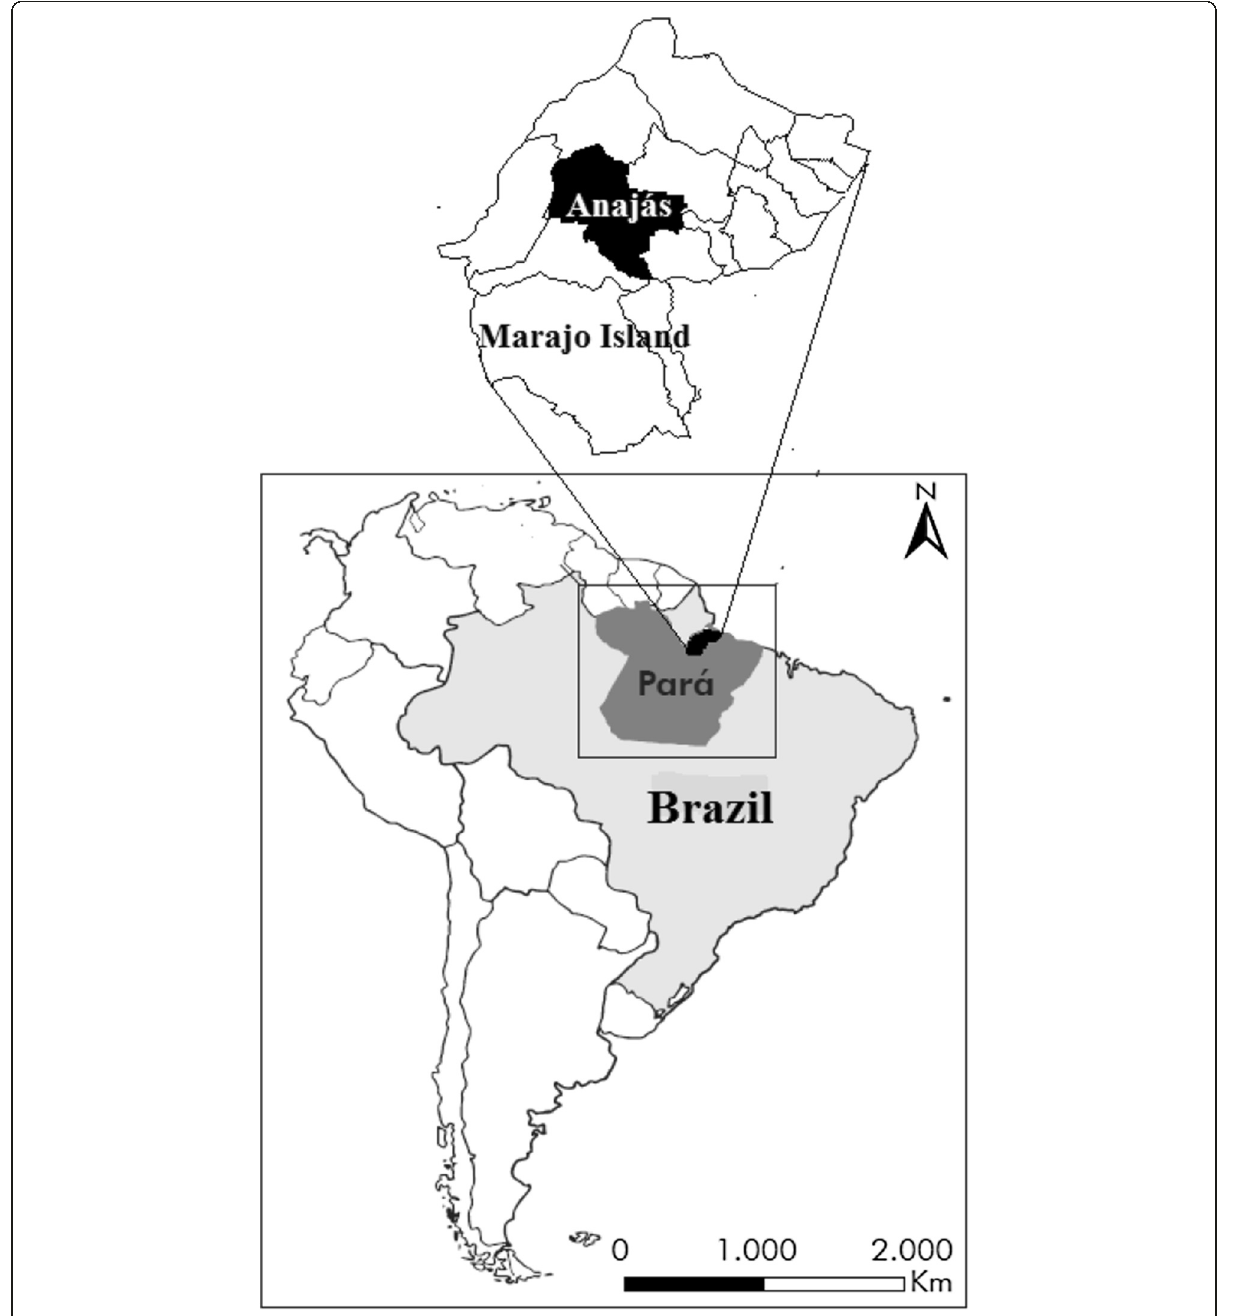
Fig. 1 Map of Marajó Island in the state of Pará, highlighting the city of Anajás, the envenomation